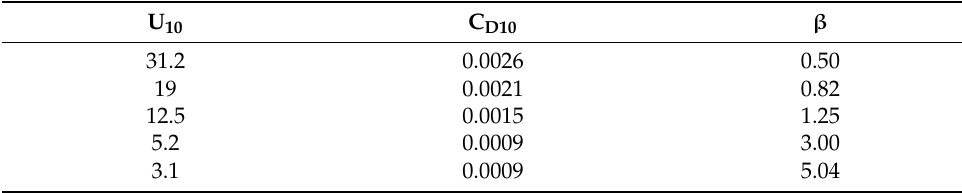
Table 3. Wind model characteristics of TEST_1, TEST_3, TEST_4 (T 10 s).